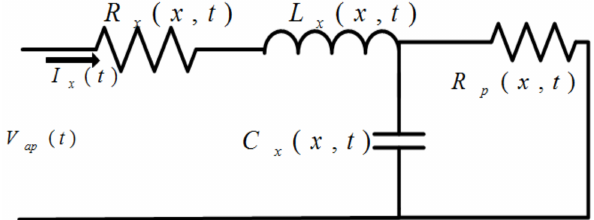
Figure 3. Electric equivalent circuit of insulator sample with single dry band near high voltage electrode.